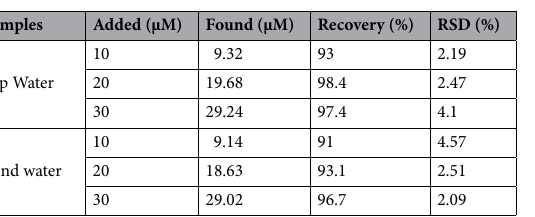
Figure 11. Stability, reproducibility, and repeatability studies of Cu/Ni/TiO 2 /MWCNTs nanocomposites modified electrode. ( a ) stability studies, ( b ) bar diagram of reproducibility for different electrodes, and ( c ) bar diagram of repeatability for the same electrode.